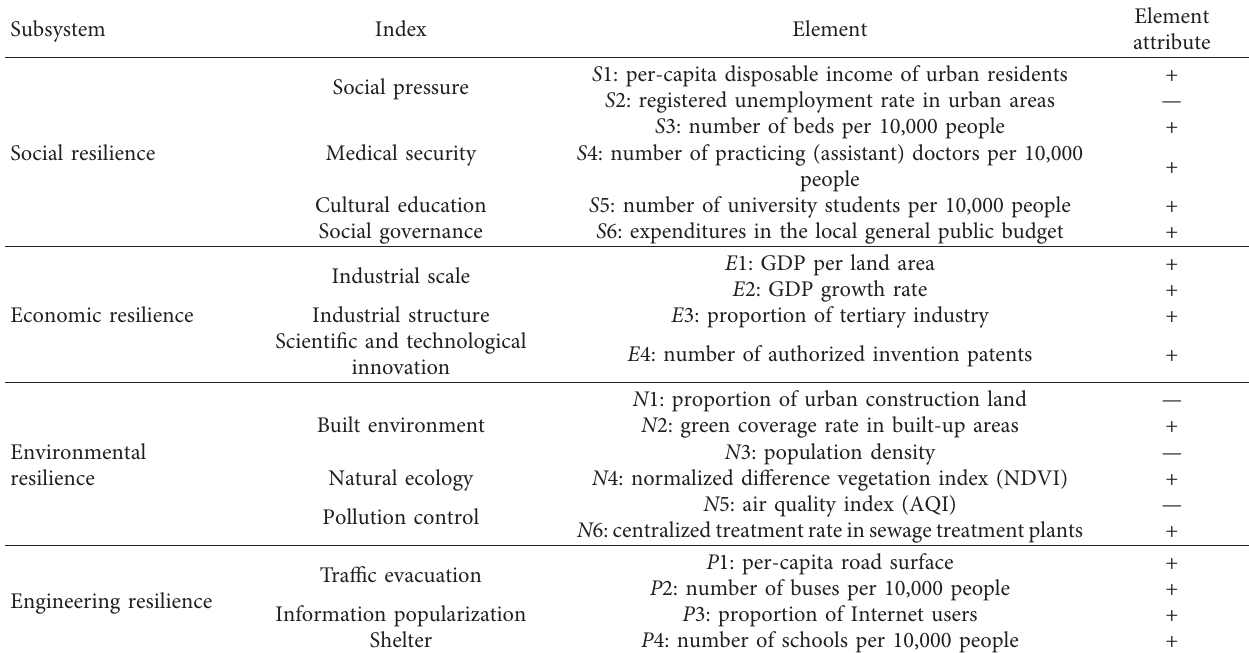
Table 2: Index system for influential elements of the urban resilience level